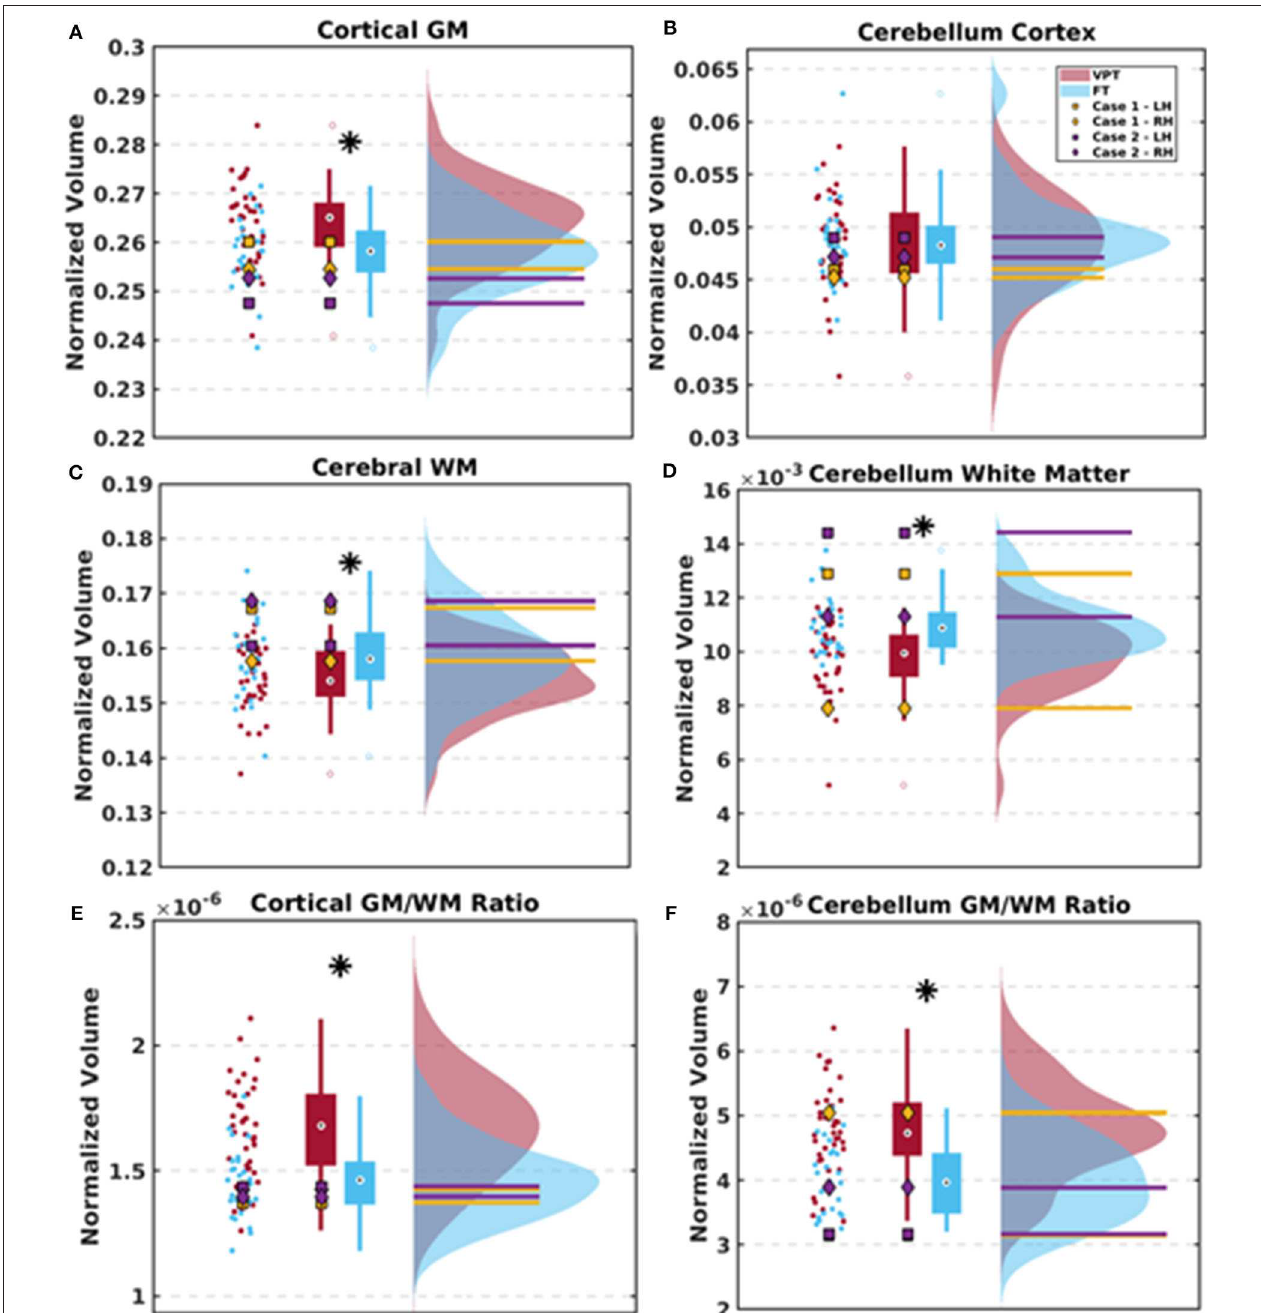
FIGURE 3 | Scatter plots, box plots, and histograms are used to depict the results between the VPT and FT group as well as the two cases. (A–D) Group differences between the ratios of cortical gray matter (GM), cerebral white matter (WM), cerebellar GM, and cerebellar WM volumes adjusted for total brain volumes. Data for the VPT and FT control groups are averaged across left and right hemispheres. (E,F) Group differences in the ratios of cortical and cerebellar GM to WM after adjusting for total brain volume. Case 1 is depicted in yellow and Case 2 is depicted in purple, with measures separated by left (LH) and right hemispheres (RH) due to some brain asymmetries. * indicates significant group differences following FDR threshold of